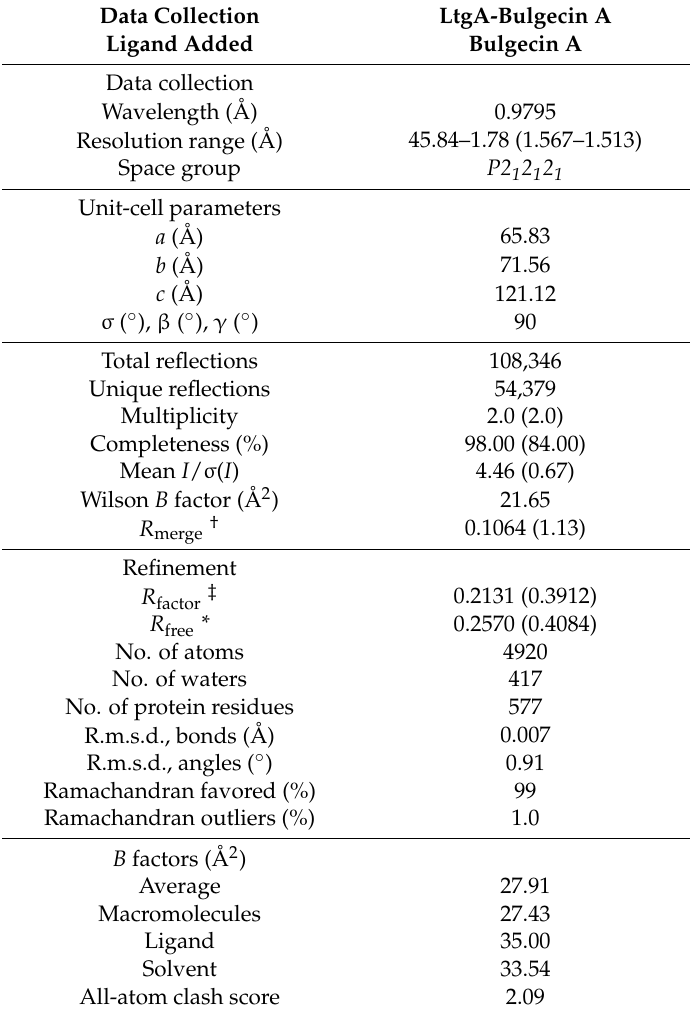
Table 1. Data-collection and refinement